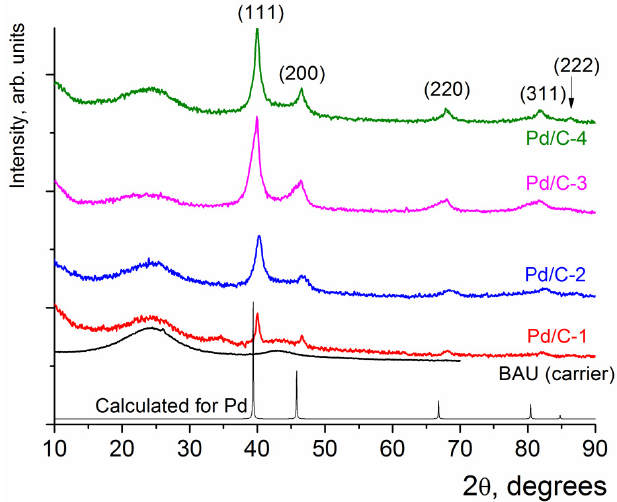
Figure 3. XRD patterns for Pd/C-1, Pd/C-2, Pd/C-3, and Pd/C-4 composites.